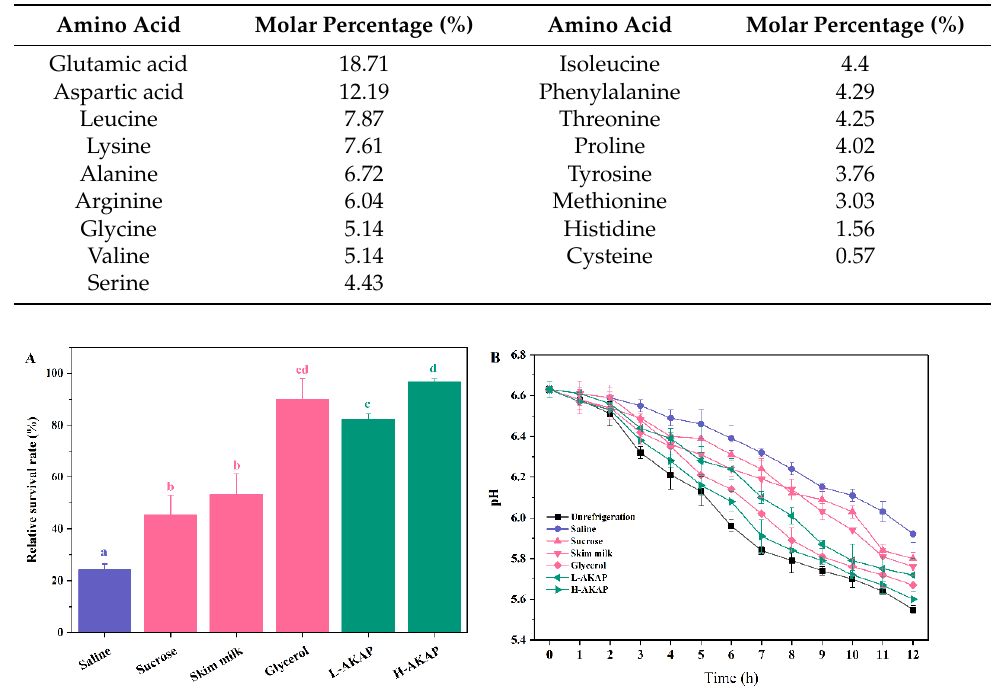
Figure 3. Effects of the negative control (saline), positive controls (1 mg/mL sucrose, 1 mg/mL skim milk, and 20% glycerol), 0.5 mg/mL antifreeze peptides from defatted Antarctic krill (AKAP) (L-AKAP), and 1 mg/mL AKAP (H-AKAP) on the ( A ) growth and ( B ) pH values of L. rhamnosus after freezing. The unrefrigeration group in ( B ) did not experience the freezing process. Bars with different lowercase letters (a, b, c, and d) indicate significant differences ( p < 0.05).